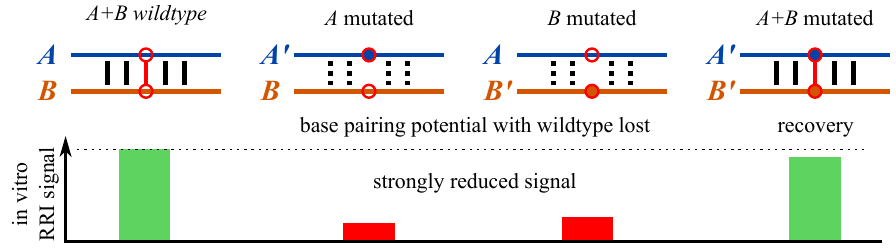
Figure 1. Depiction of an RNA-RNA interaction verification experiment based on compensatory mutations of two RNA sequences A and B . The mutated nucleotides are highlighted by red circles. The lost and regained base pair is given as red line. Black solid lines depict likely formed RRI base pairs, while unlikely base pairs (instable due to reduced RRI) are represented in dotted